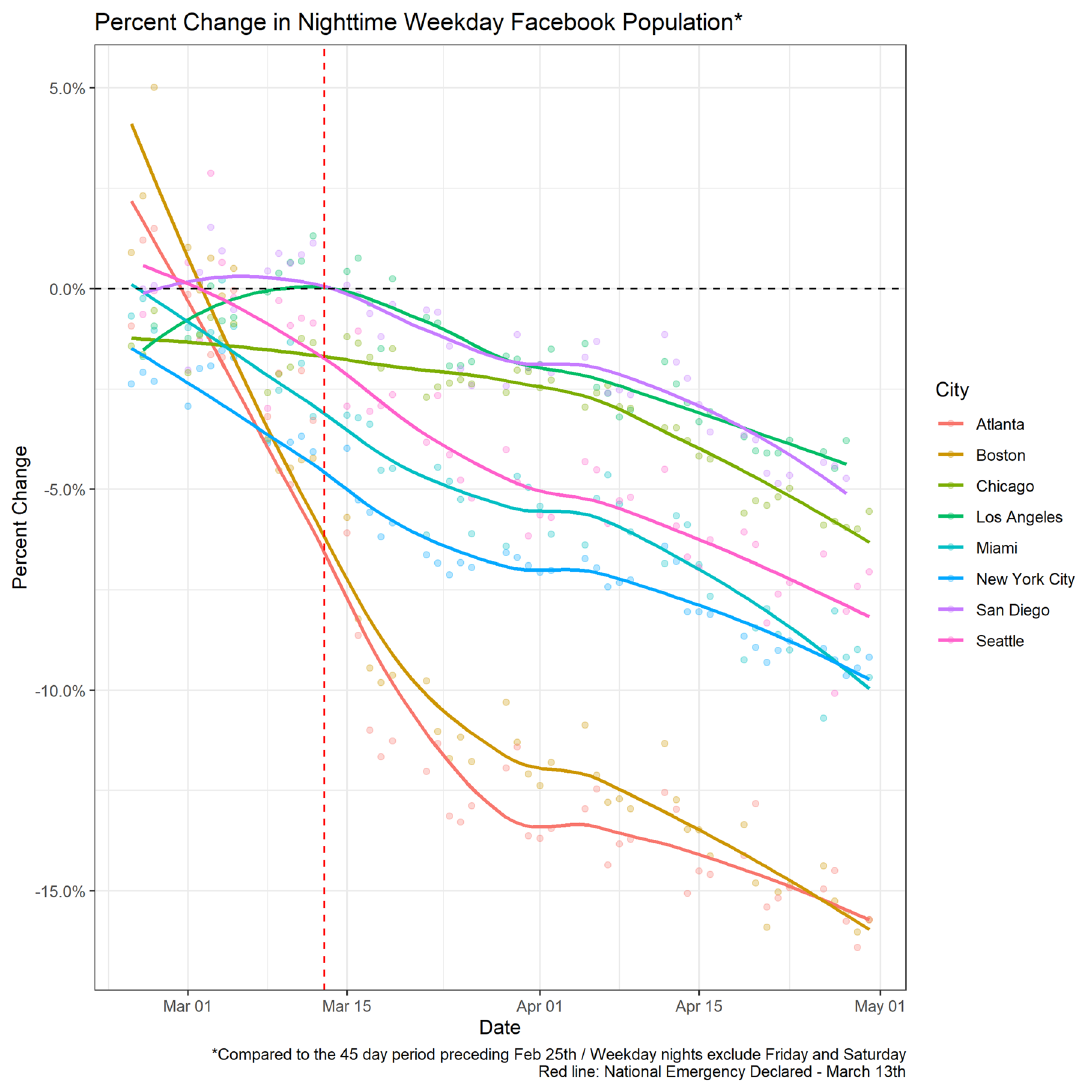
Figure 2. Percent change in weekday nighttime population of Facebook users by city. We can see that all cities included in the Facebook sample experience a decrease in nighttime population over the period of interest. The vertical red dotted line is when potential national COVID-19 restrictions were